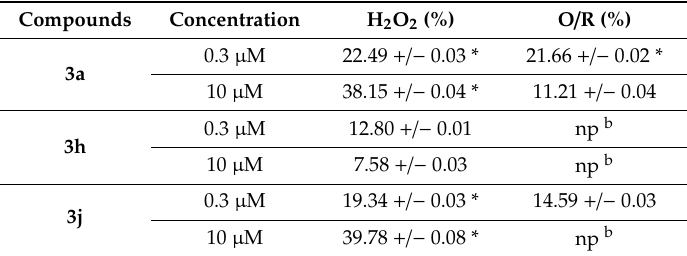
Table 2. Neuroprotective activity of compounds 3a , 3h and 3j on H 2 O 2 (200 µ M) or oligomycin (O